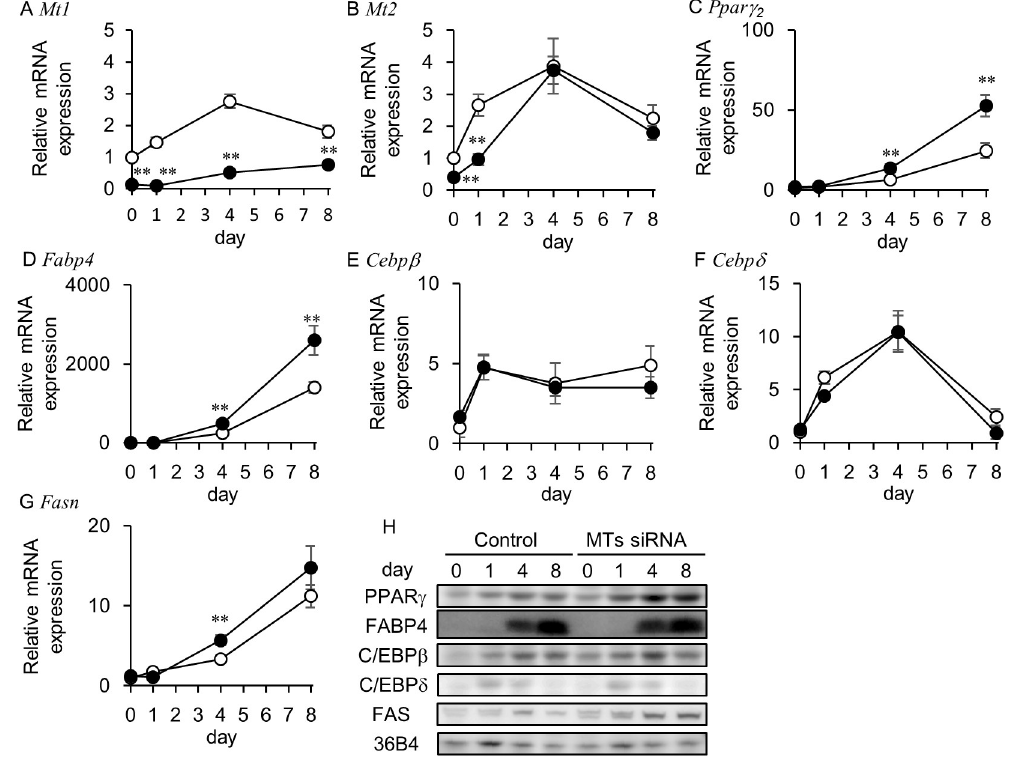
Fig 2. Effects of MTs siRNA on the expressionof MTs and adipocyte-related genes and proteins. 3T3-L1 preadipocytes were treated with 50 nM control RNA (open circle) or MTs siRNA (closedcircle) 24 h before the additionof DIM (day -1). Total RNA was isolatedon day 0, 1, 4, and 8, and the expressions of (A) mt1 , (B) mt2 , (C) ppar γ ,(D) fabp4 , (E) cebp β ,and (F) cebp δ ,were determined using real-time PCR. All mRNA levels were normalized to the expressionlevel of the 36B4 gene and are shown as fold inductionfrom the control RNA-treated cells on day 0. Data are expressedas the mean ± SD ( n = 3). ** P < 0.01, comparedwith control RNA-treated cells at the same time point. (G) Cell lysates from the control RNA-treated cells (control) and the MTs siRNA-treated cells (MTs siRNA) were obtainedat the indicatedpoints. The protein expressionof PPAR γ , FABP4, C/EBP β , C/EBP δ , and FAS (with 36B4 as a loadingcontrol) during the adipogenicdifferentiation of 3T3-L1 cells was determinedusing